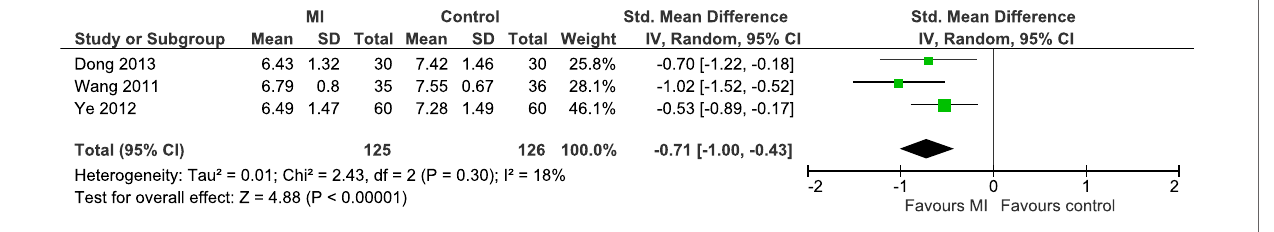
FiGURe 3 | Meta-analysis illustrating the standardized effects of motivational interviewing (Mi) vs. control for glycated hemoglobin